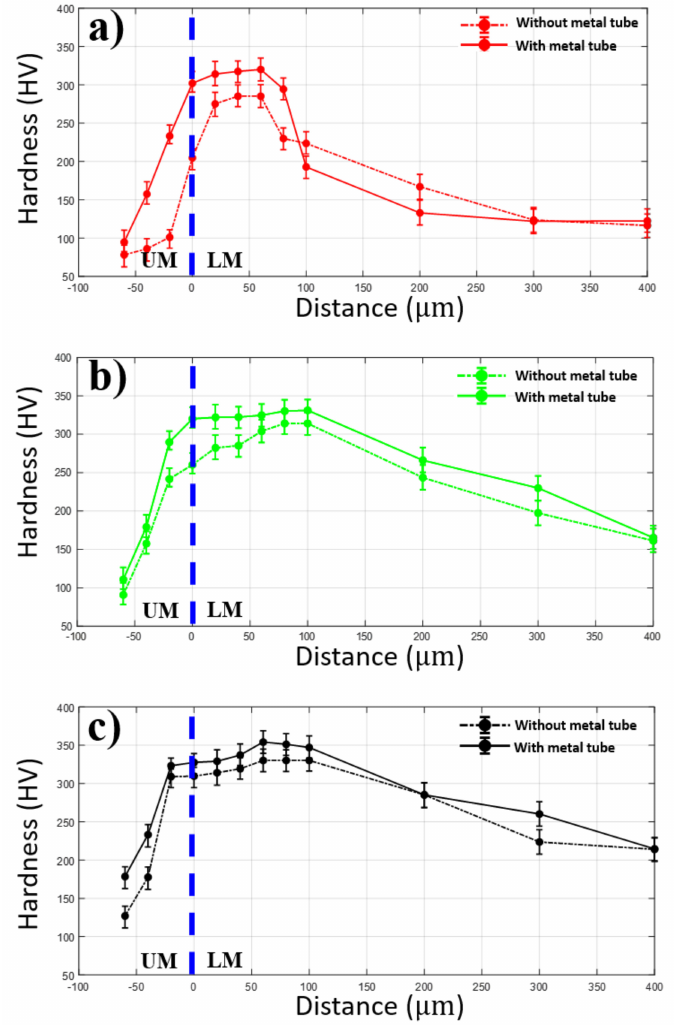
Figure 12. Hardness following the vertical direction. ( a ) 10 W, ( b ) 15 W, ( c ) 20